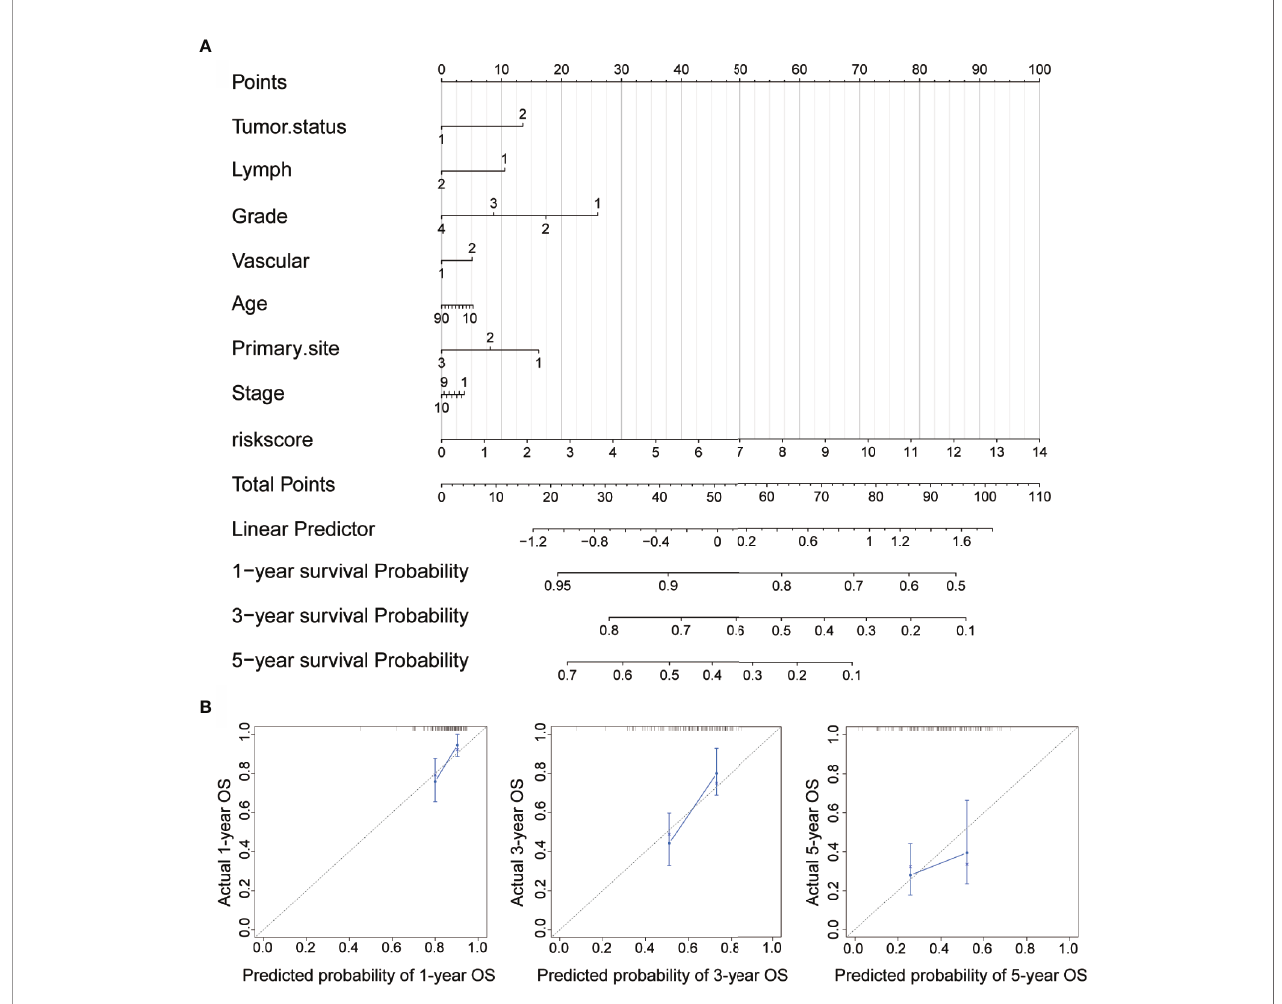
FIGURE 7 | Construction of nomogram for survival prediction. (A) Nomogram combining the signatures with clinicopathological features. (B) Calibration plot showing that the nomogram-predicted survival probabilities correspond closely to the observed